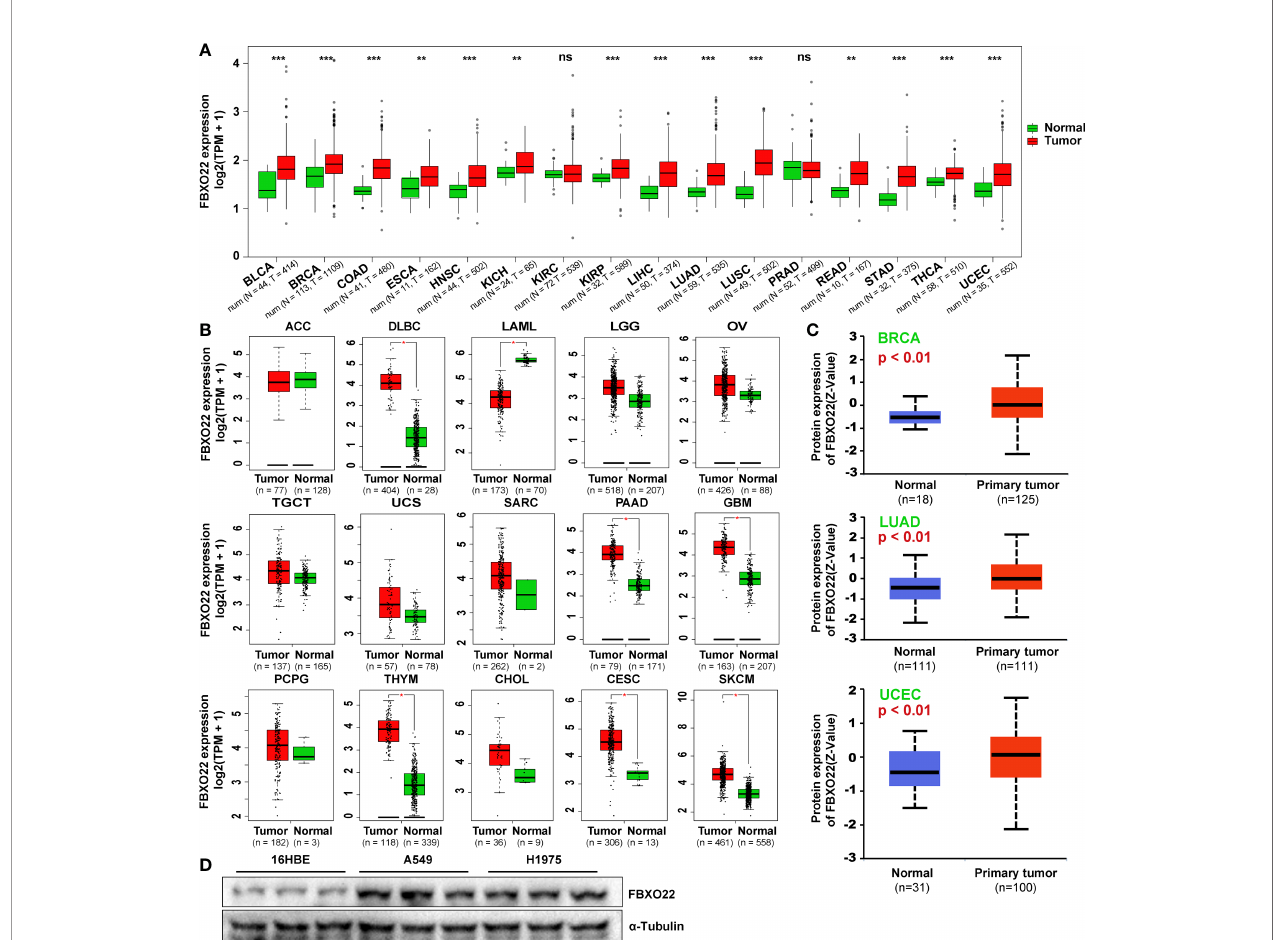
FIGURE 1 | FBXO22 expression in human tumors and healthy tissues. (A) FBXO22 expression levels in BLCA, BRCA, COAD, ESCA, HNSC, KICH, KIRC, KIRP, LIHC, LUAD, LUSC, PRAD, READ, STAD, THCA, and UCEC from TCGA database. (B) Analysis of ACC, DLBC, LAML, LGG, OV, TGCT, UCS, SARC, PAAD, GBM, PCPG, THYM, CHOL, CESC, and SKCM in TCGA using GEPIA2; corresponding healthy tissues from the GTEx database were included as controls. (C) Total FBXO22 protein expression levels in healthy and primary breast cancer, lung adenocarcinoma, and UCEC tissue, based on the CPTAC dataset from UALCAN. (D) Total FBXO22 protein levels in human lung cancer and bronchial epithelial cell lines. ns, no signi fi cant difference; * p < 0.05; ** p < 0.01; *** p <